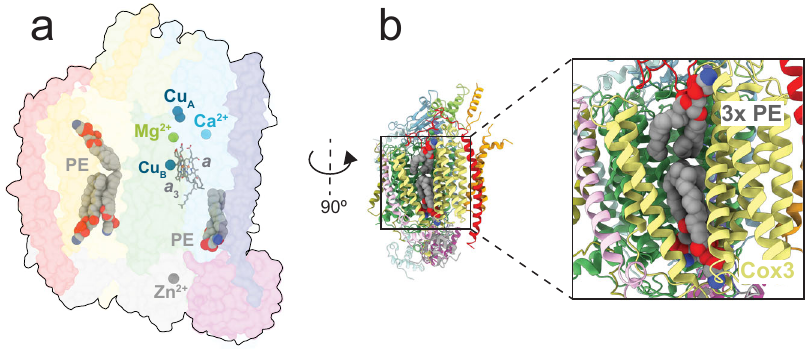
Fig. 2 Lipids, redox-active cofactors and non-redox-active metal sites. a Density for four phosphatidylethanolamine (PE) molecules was clearly resolved. The redox-active metal sites are Cu A , heme a as well as the heme a 3 -Cu B catalytic site. Non-redox-active Zn 2 + , Ca 2 + and Mg 2 + sites were modelled as discussed in the text. b Three PE lipids in the V-shaped cleft of Cox3 (see